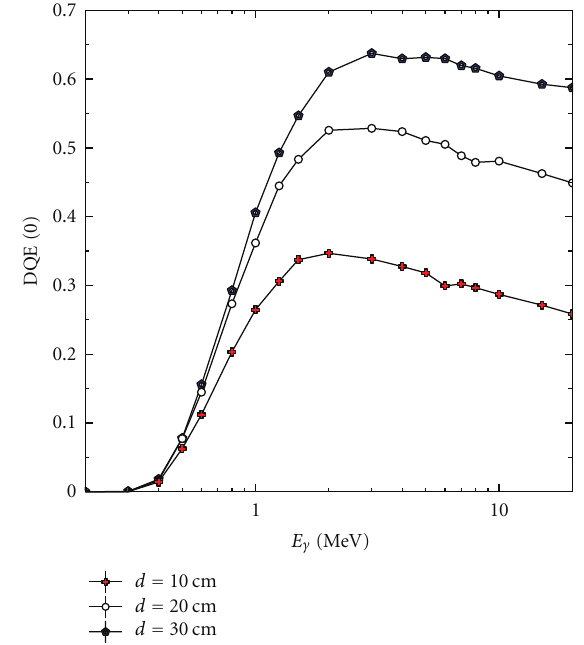
Figure 12: The DQE at zero spatial frequency as a function of beam energy for di ff erent detector